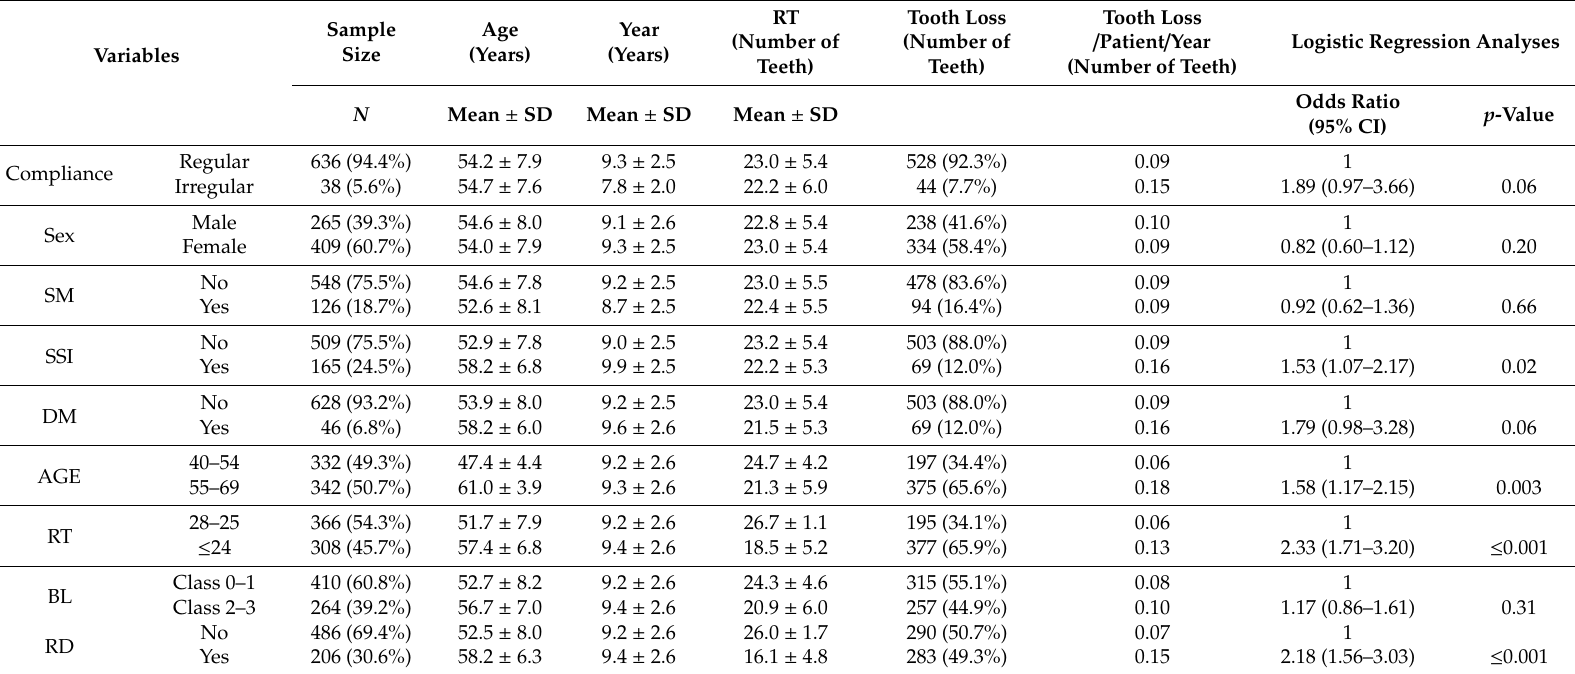
Table 4. Characteristics of study variables and relationships with tooth